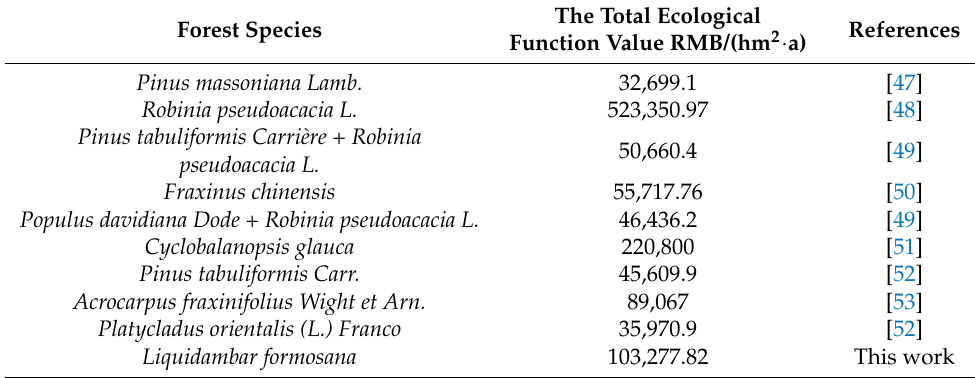
Table 11. Comparison of the total ecological function value of Liquidambar formosana plantation and other